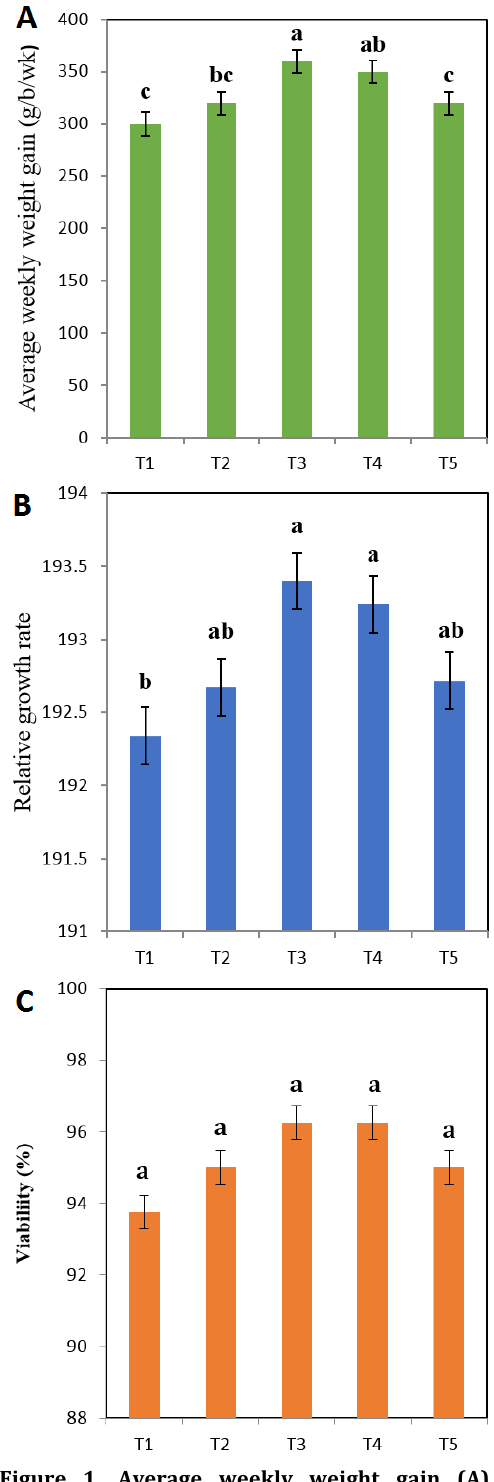
Figure 1. Average weekly weight gain (A), relative growth rate (B), and viability of broiler chickens fed with seed supplemented diets. T1: Control; T2: Oxytetracycline (0.11g/kg); T3: Pawpaw seed meal (15g/kg); T4: Mustard seed meal (15g/kg); T5: Black cumin seed meal